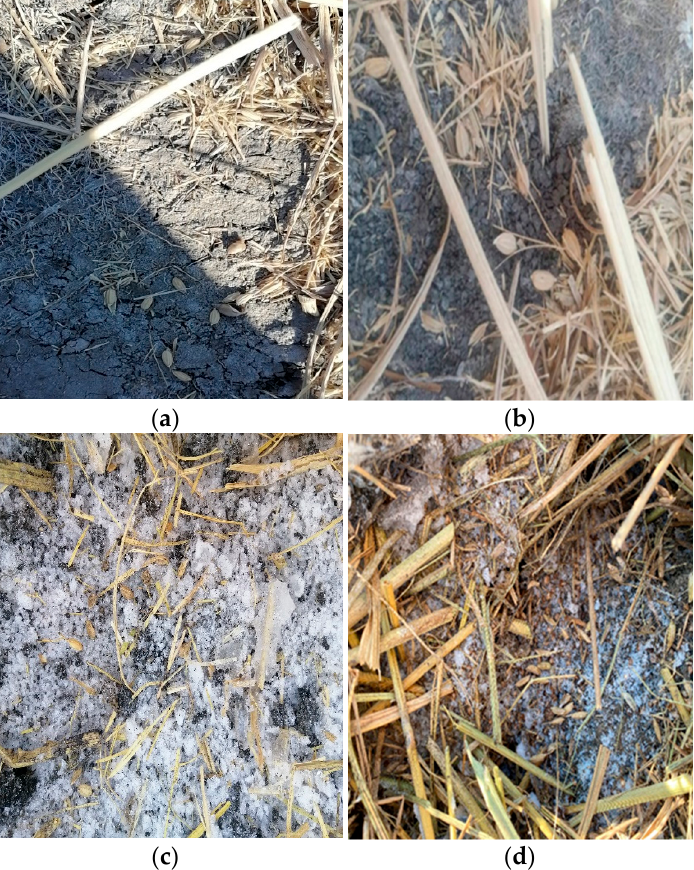
Figure 3. The state of grain shattering in each region: ( a ) Grain shattering in Taonan, ( b ) Taobei, ( c ) Jiutai, and ( d ) Jilin.